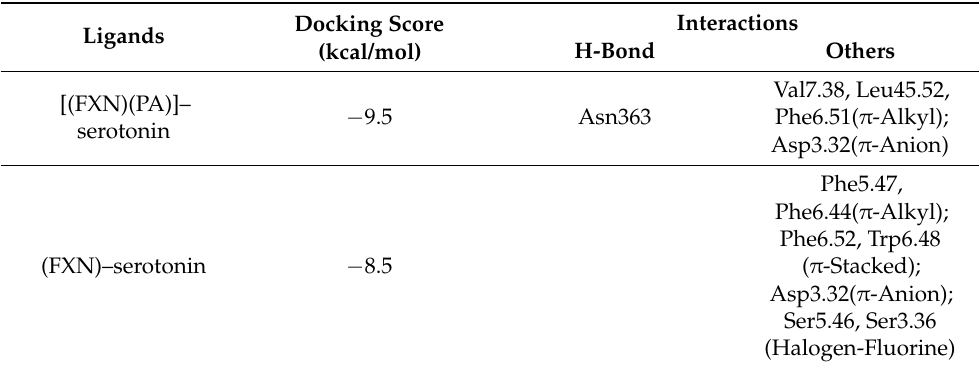
Figure 5. Best-docked pose showing a helical model of ( a ) [(FXN)(PA)]–serotonin; ( b ) (FXN)–serotonin. Table 2. Interaction data of [(FXN)(PA)]–serotonin and (FXN)–serotonin (PDB ID: 6A94).